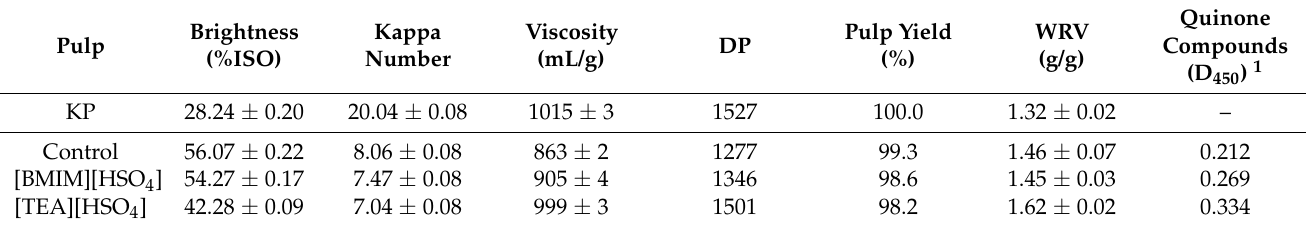
Table 2. The effect of ILs pretreatment on the properties of eucalyptus kraft pulps in the oxygen delignification process.